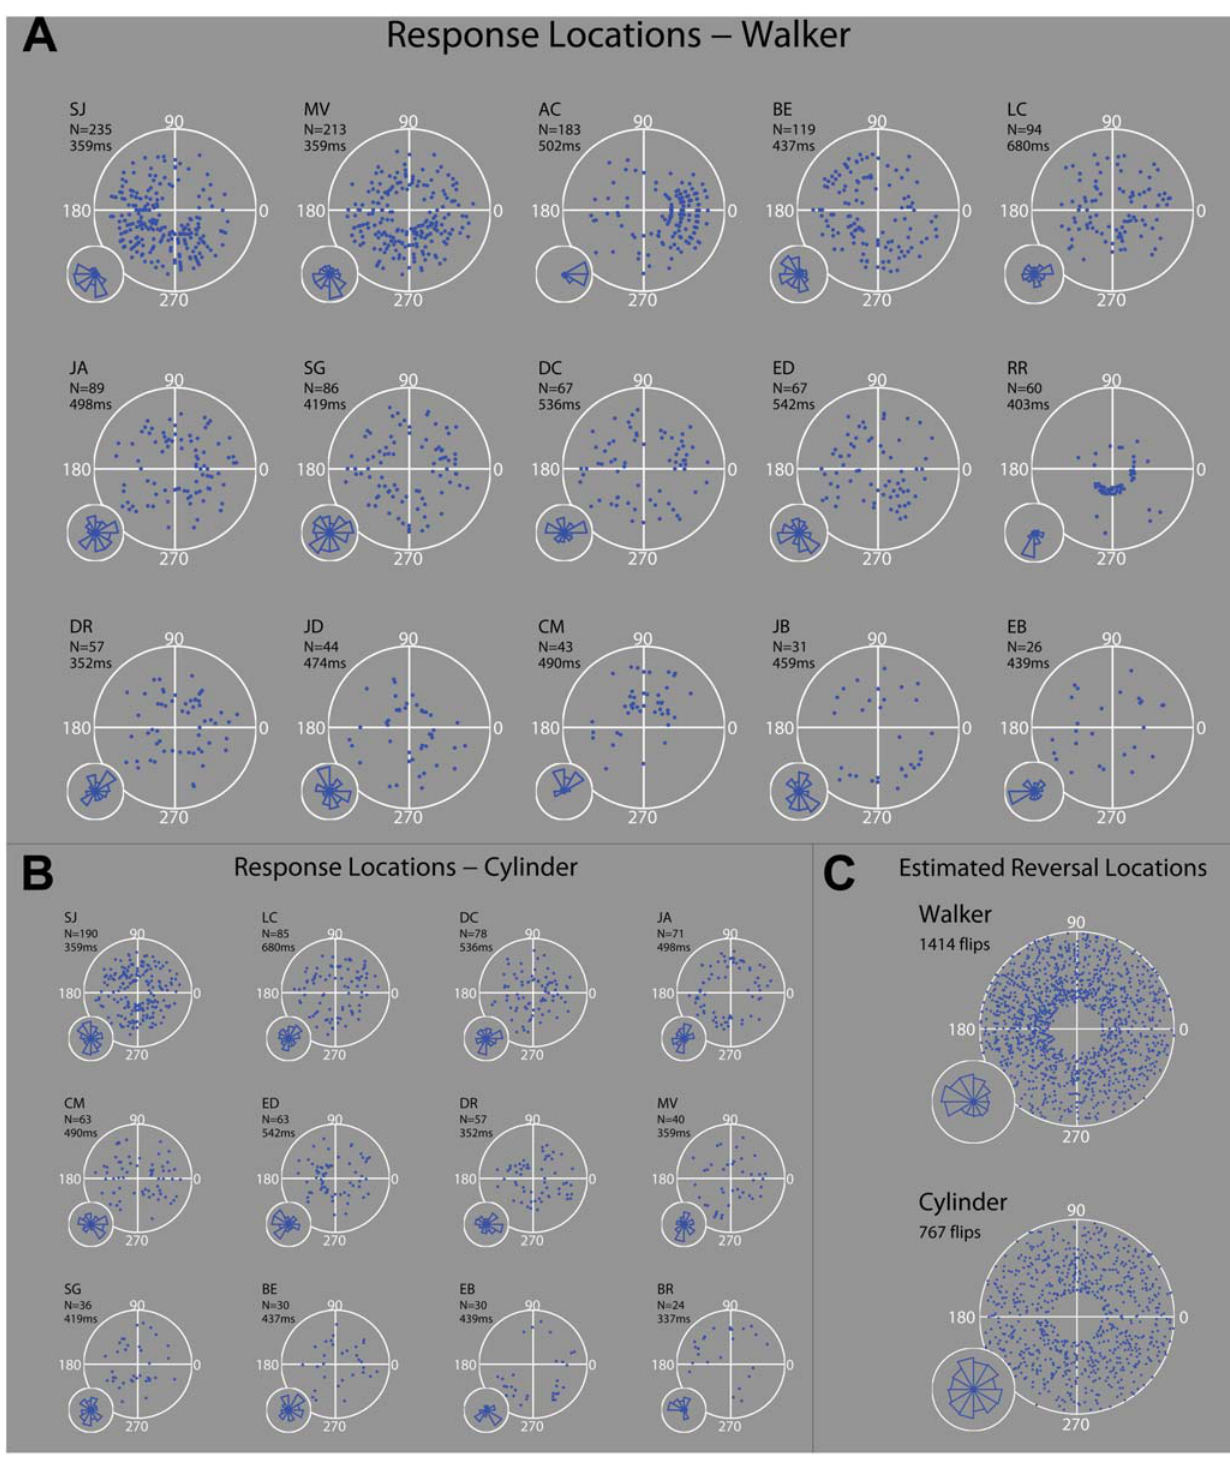
Figure 5. Response location distributions. (A) The polar plots depict the locations of observers’ button responses relative to the walker’s rotation cycle (Experiment 1). Distance from the centre of the polar plot illustrates how far in time into a trial a response occurred i.e. successive rotation periods span out from the centre in concentric pattern. Note that an artificial gap is added to the centre of each plot, to avoid crowding of dots in the centre. Histograms (inset; 30 u bins) illustrate the proportion of these responses falling in set angular segments of the rotation. The plots are given in order of reversal frequency (high frequency trials at top). For space constraints, data from some very low switchers (approx. 1 rev/min or less over the ten-minute trials) are not included. An estimate of each observer’s reaction time, taken from the mean RT in a control trial, is given above each plot. (B) Reversal location distributions for the cylinder trials (extremely low switchers excluded). (C) From each observer’s data, we estimated the walker’s orientation at the time of perceptual reversal by subtracting a set angular amount from the response location data, based on the observer’s mean reaction time in a control trial (1 rotation cycle=1000 ms). The plots illustrate the RT-corrected data pooled from all observers.